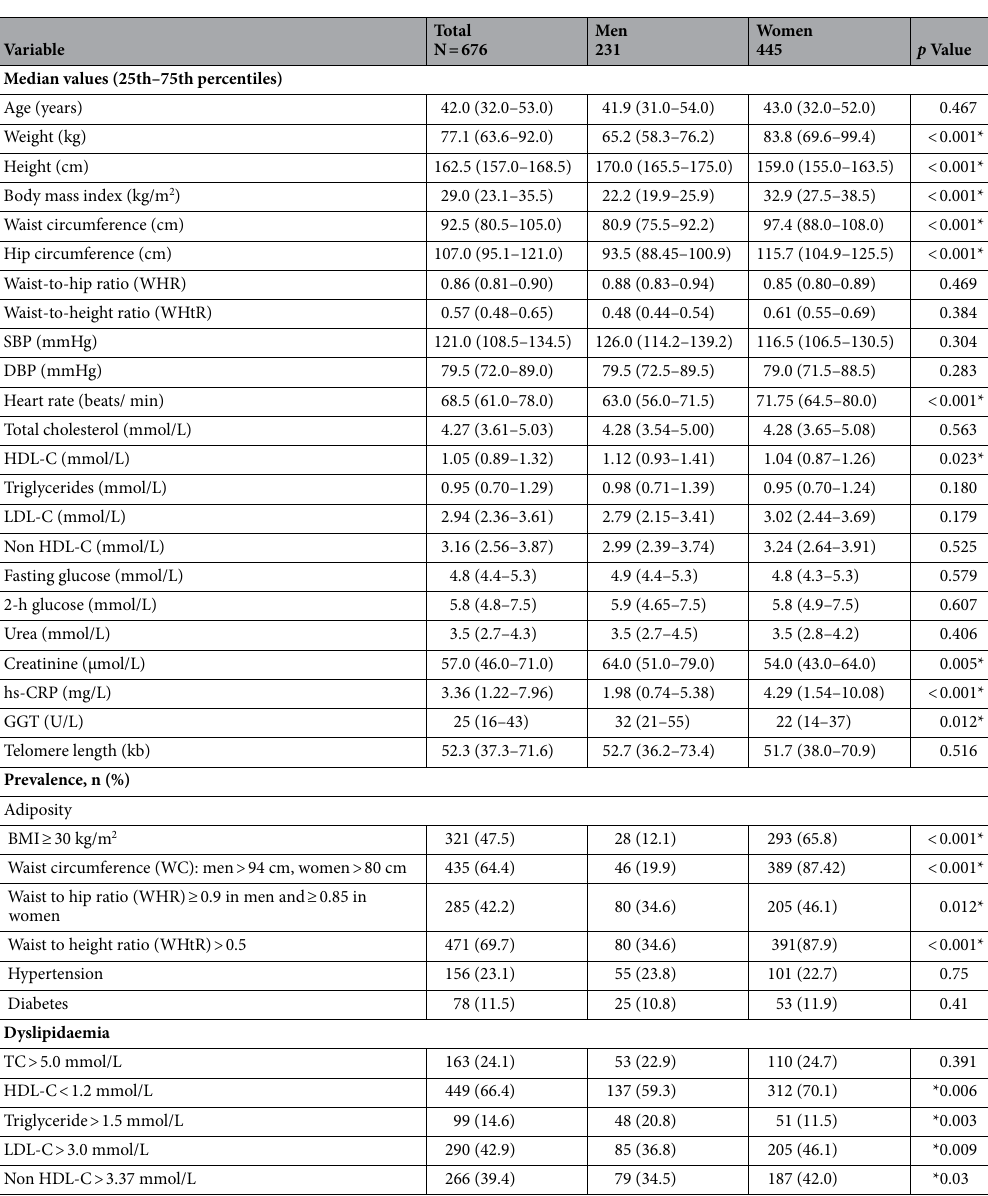
Table 1. Cardiometabolic characteristics of the study population. Legend: SBP systolic blood pressure, DBP diastolic blood pressure, WC waist circumference, WHR waist to hip ratio, WHtR waist to height ratio, HDL- C high-density lipoprotein cholesterol, LDL-C low-density lipoprotein cholesterol, GGT gamma glutamyl transferase, hs-CRP highly sensitive c-reactive protein. * means there is significant difference in the variable comparing men with